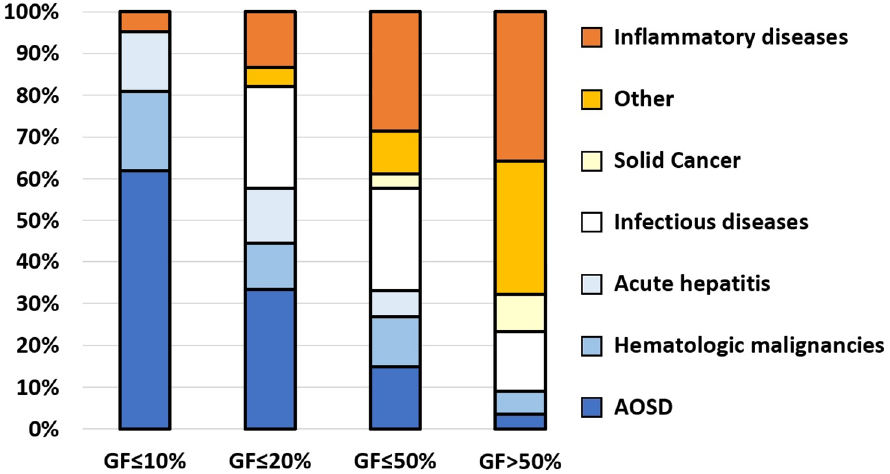
Figure 2. Cause prevalence according to the glycosylated ferritin (GF) level in adult-onset Still’s disease (AOSD) and control subgroups.